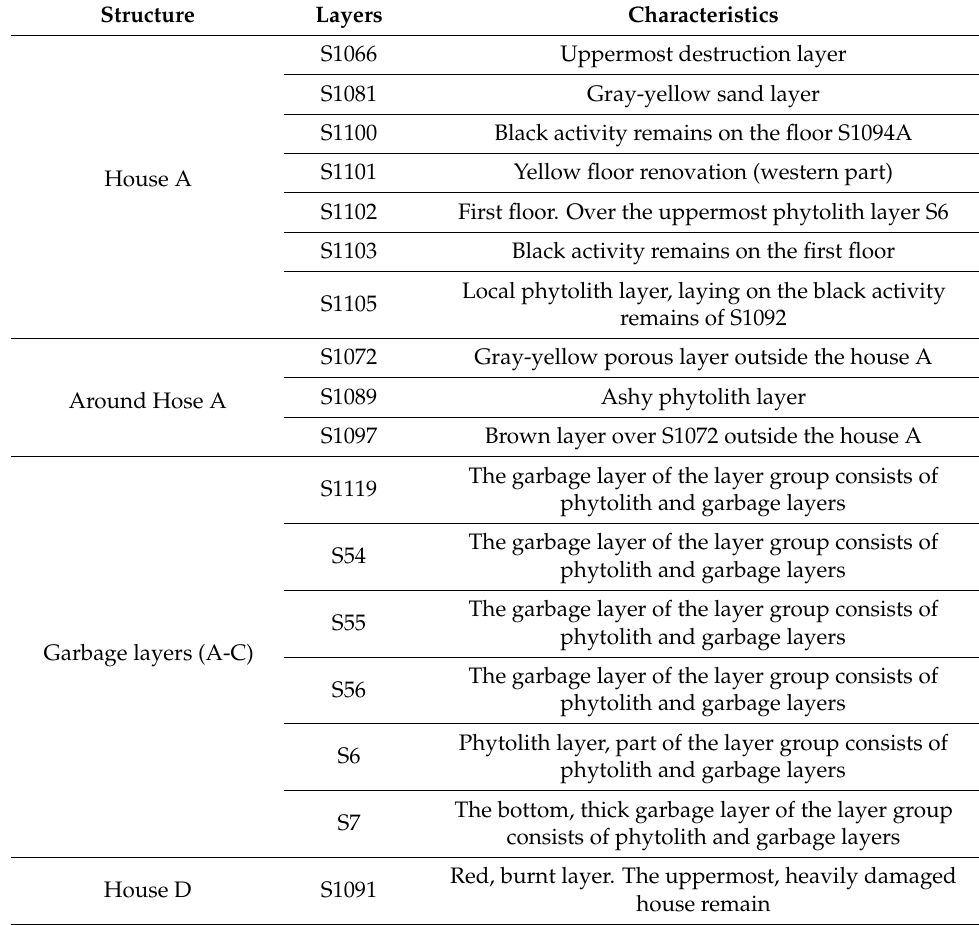
Table 1. Characteristics of Borsodiv á nka